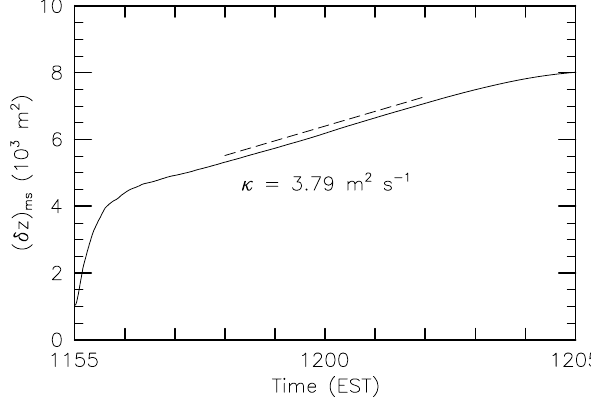
Fig. 8. Time evolution of (δz) ms (t) and resulting turbulent diffu- sivity K L at 12:00EST. The dashed line corresponds to the least- square curve fit of (δz) ms (t) , which is used to estimate K L